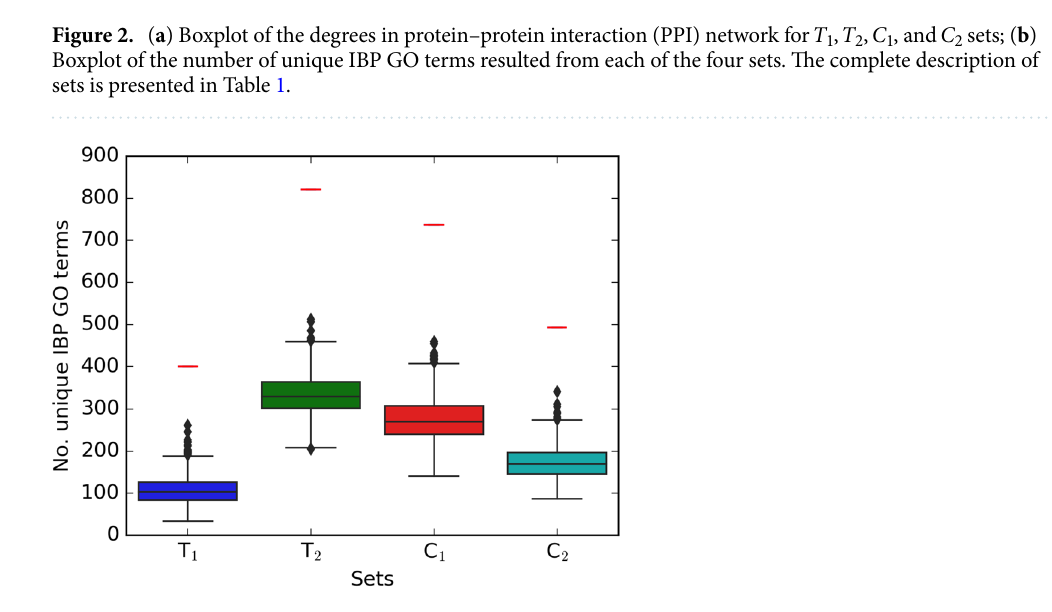
Figure 3. Boxplot of number of unique IBP GO terms resulted from 1000 randomly selected sets of sizes 20, 71, 57, and 34, respectively. Red small lines in the figure are the number of unique IBP GO terms for T 1 , T 2 , C 1 and C 2 sets. The complete description of sets is presented in Table